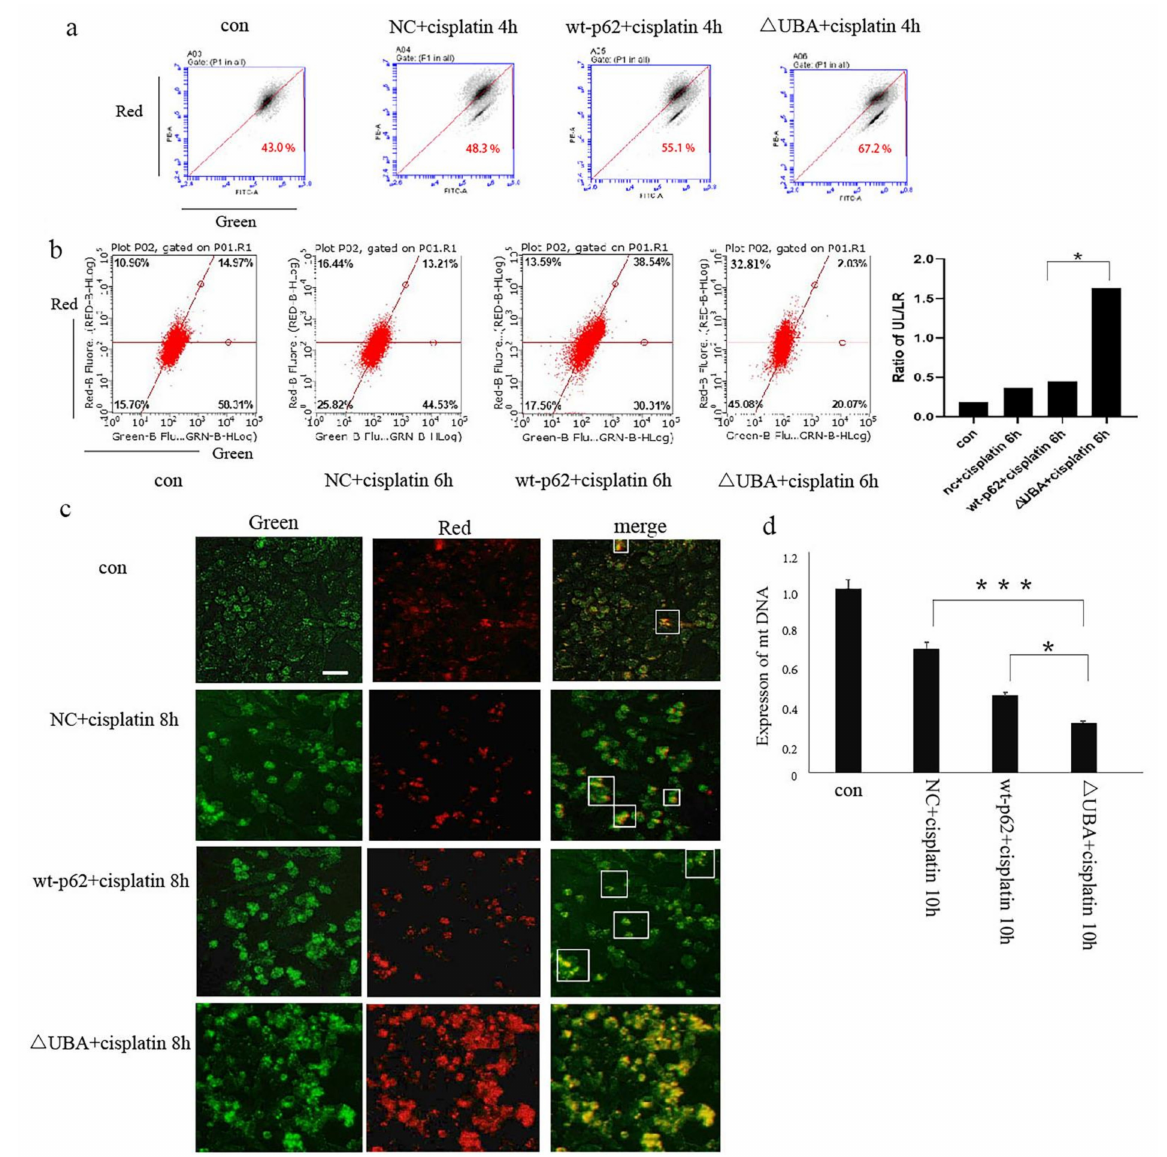
Figure 4. Mitophagy increases after UBA domain mutation. ( a ). JC-1was used to evaluate (cid:52) ϕ m in A2780 cells transfected with wt-p62 or ∆ UBA-p62 and treated with cisplatin 5 µ g/mL for 4 h. ( b )., ( c ). After transducing lentivirus mt-keima-COX8, A2780 cells were transfected with wt-p62 or ∆ UBA-p62, then treated with cisplatin 5 µ g/mL for 6 h, fluorescence was visualised using microscopy and flow cytometry analysis. Scale bar, 50 µ m. Data are presented as mean ± SD, n = 3. * p < 0.05 vs. wt-p62. ( d ). RT-PCR detection of mitochondrial copy number in A2780 cells transfected with wt-p62 or ∆ UBA-p62 and treated with cisplatin 5 µ g/mL for 10 h. Data are presented as mean ± SD, n = 3. * p < 0.05 vs. wt-p62. *** p < 0.001 vs.